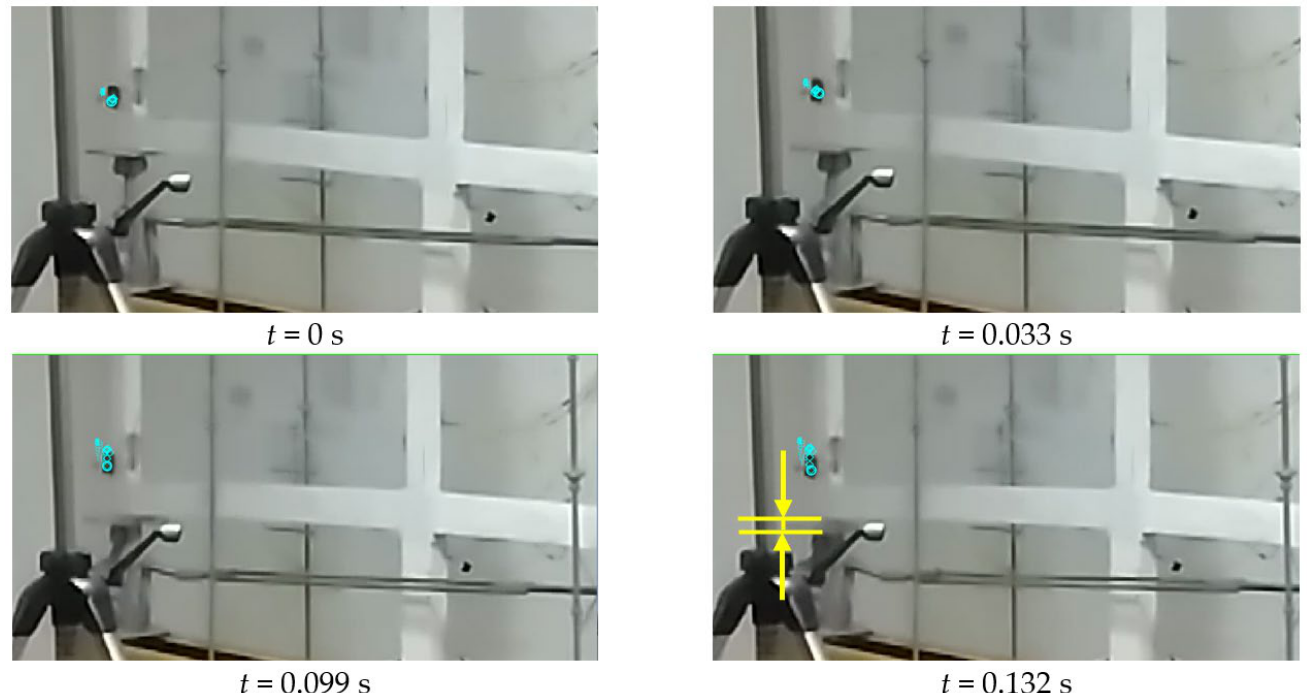
Figure 8. Displacement of the beam-to-column joint after removal of the corner column.